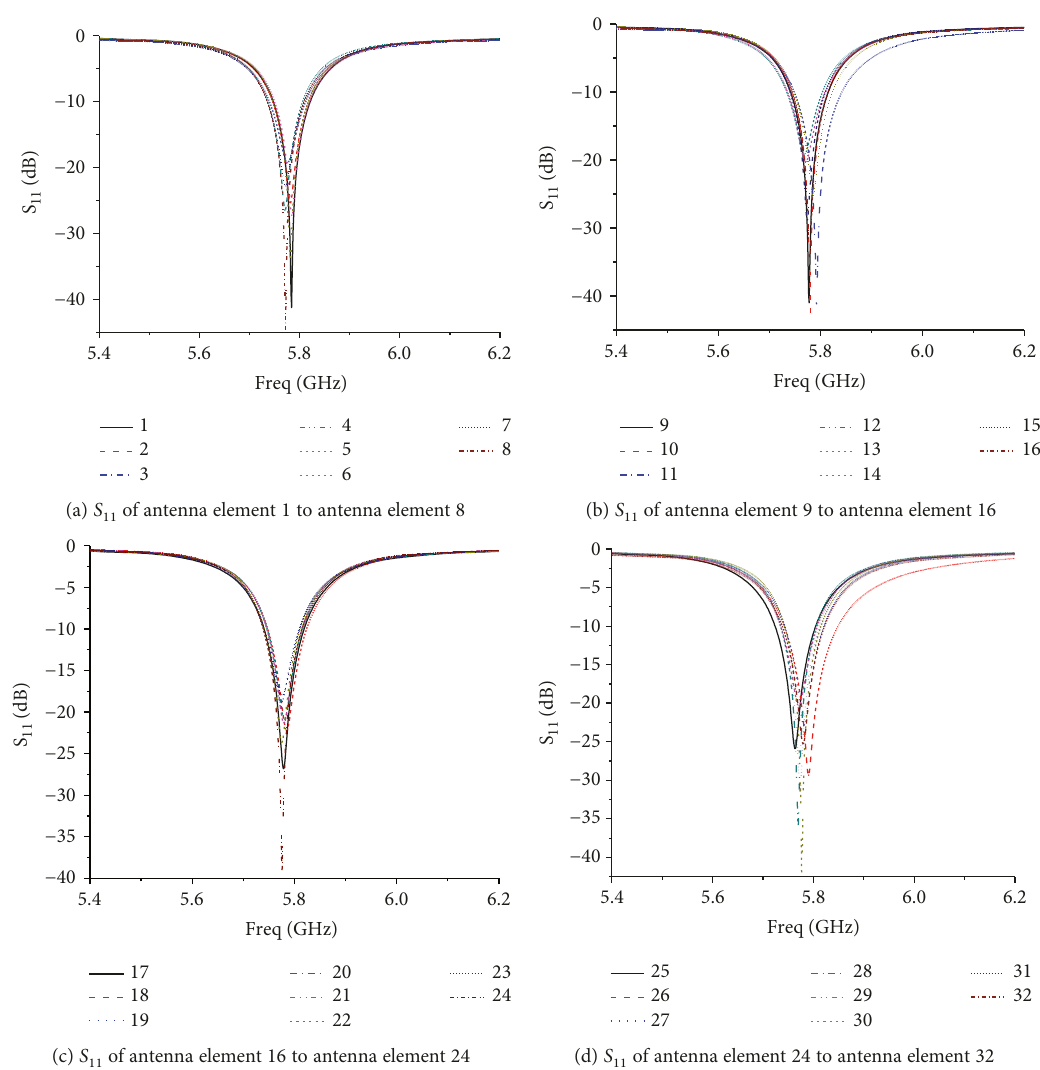
Figure 16: Measured return